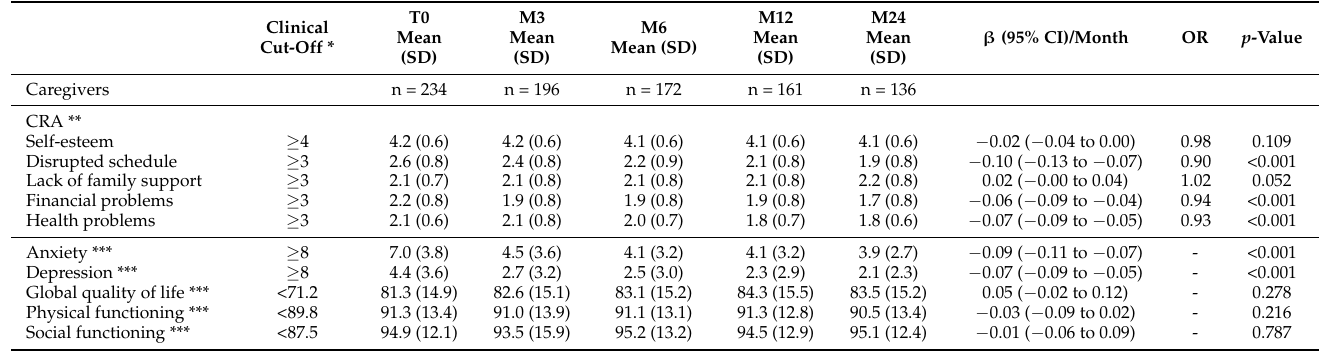
* Clinical cut off scores represent: clinically relevant symptoms for the Caregiver Reaction Assess- ment (CRA) and Hospital Anxiety and Depression Scale (HADS). For quality of life (EORTC) do- mains, the mean of the general population was used as cut-off score. ** The effect over time was calculated with cumulative logit mixed models; adjusted for caregivers’ sex, age, e ducation level, caregiver type, and patients’ disease stage, comorbidity and WHO status. *** The mean effect over time was calculated with linear mixed models; adjusted for caregivers’ sex, age, education level, caregiver type and patients’ disease stage, comorbidity and WHO status, and baseline scores on CRA subscales of self-esteem, disrupted schedule, family support, financial problems and health problems.